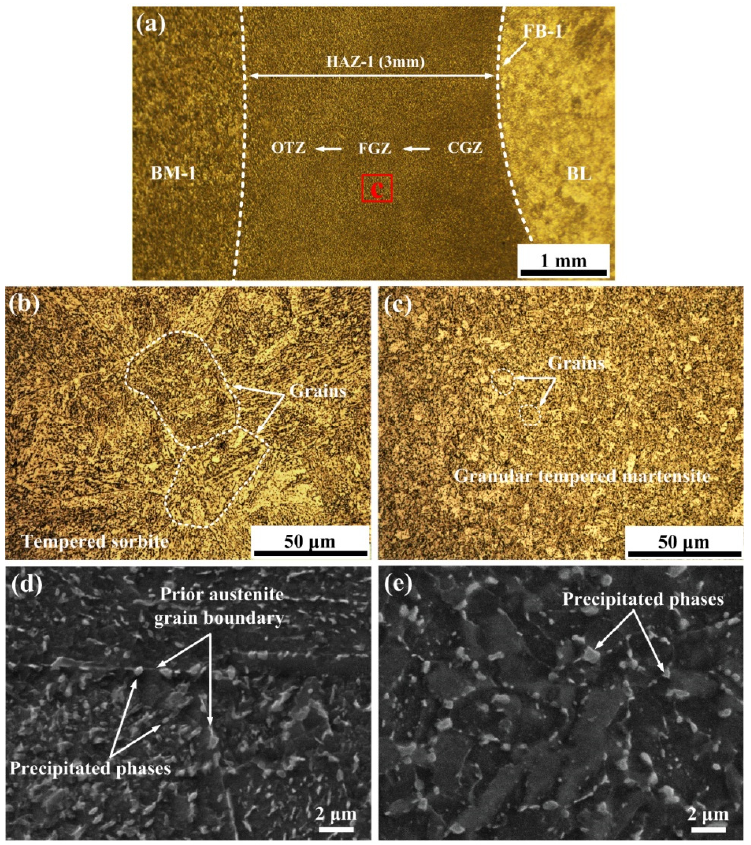
Figure 7. Microstructures of BM-1 and HAZ-1 obtained by OM and SEM. ( a ) Overall micrograph of HAZ-1. ( b ) OM micrograph of BM-1. ( c ) OM micrograph of FGZ in HAZ-1. ( d ) SEM micrograph of BM-1. ( e ) SEM micrograph of FGZ in HAZ-1.